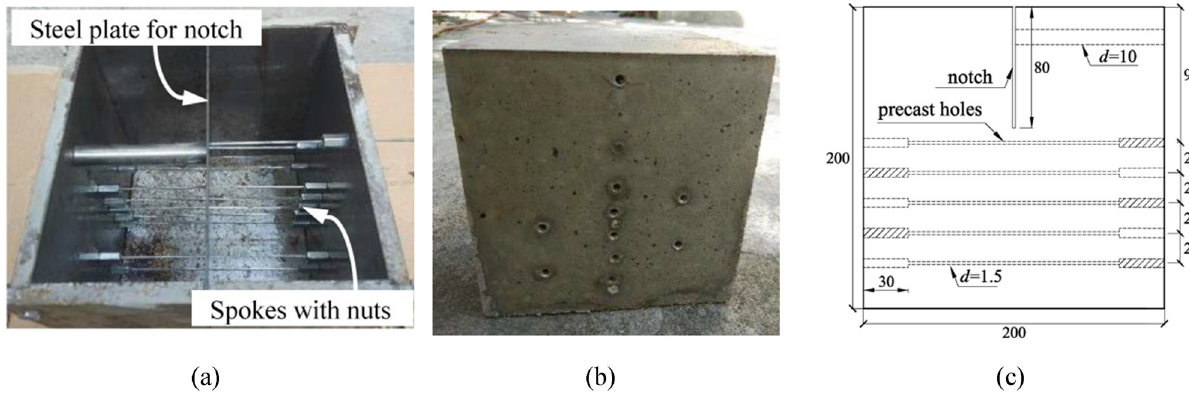
Figure 1: Con fi guration and casting of the test specimen ( unit: mm ) . ( a ) Photograph of the mold; ( b ) photograph of the specimen; and ( c ) section view along the